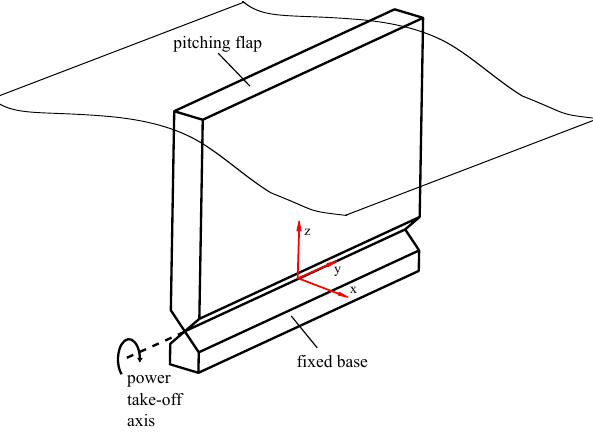
Figure 2. Schematic of the Flap WEC